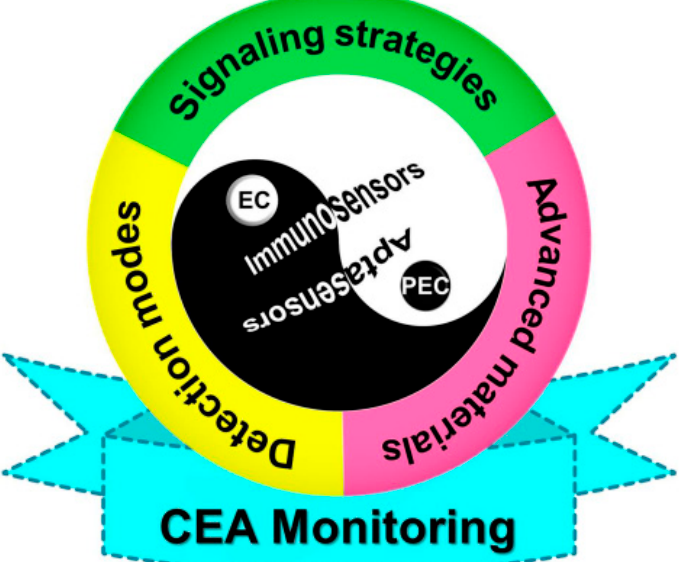
Figure 1. Overview of electrochemistry- and photoelectrochemistry-based immunosensing and aptasensing of CEA.